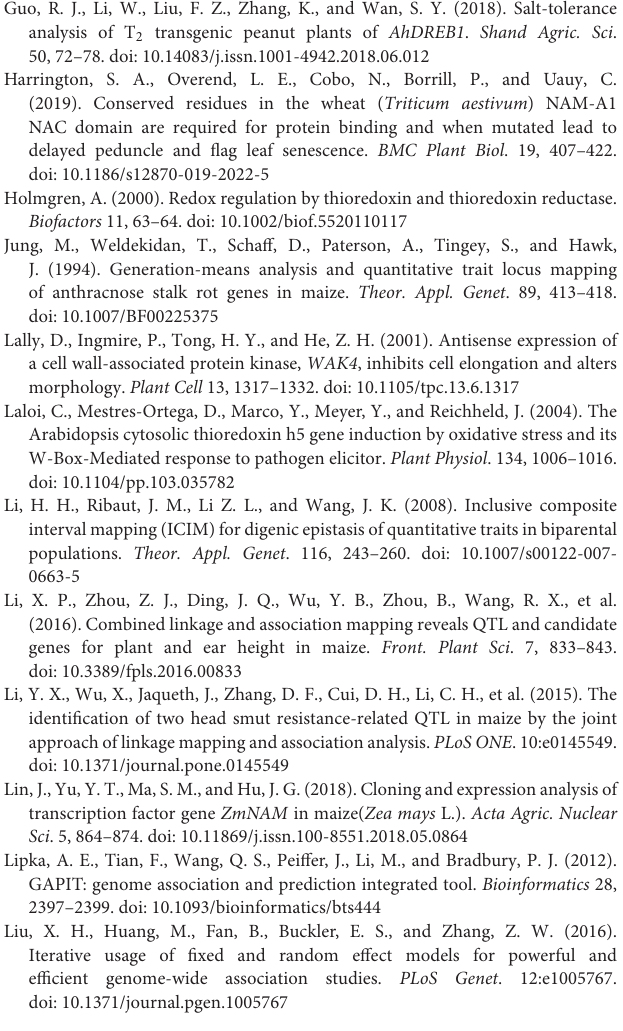
Supplementary Table 1 | The list of 165 maize inbred lines. Supplementary Table 2 | qRT-PCR